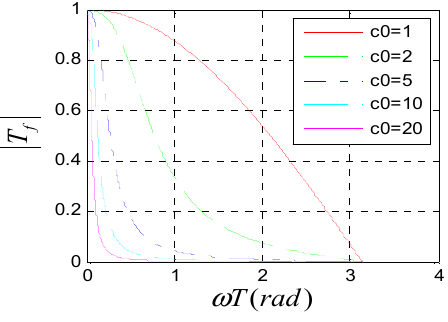
Figure 12. Nyquist diagram of Equation